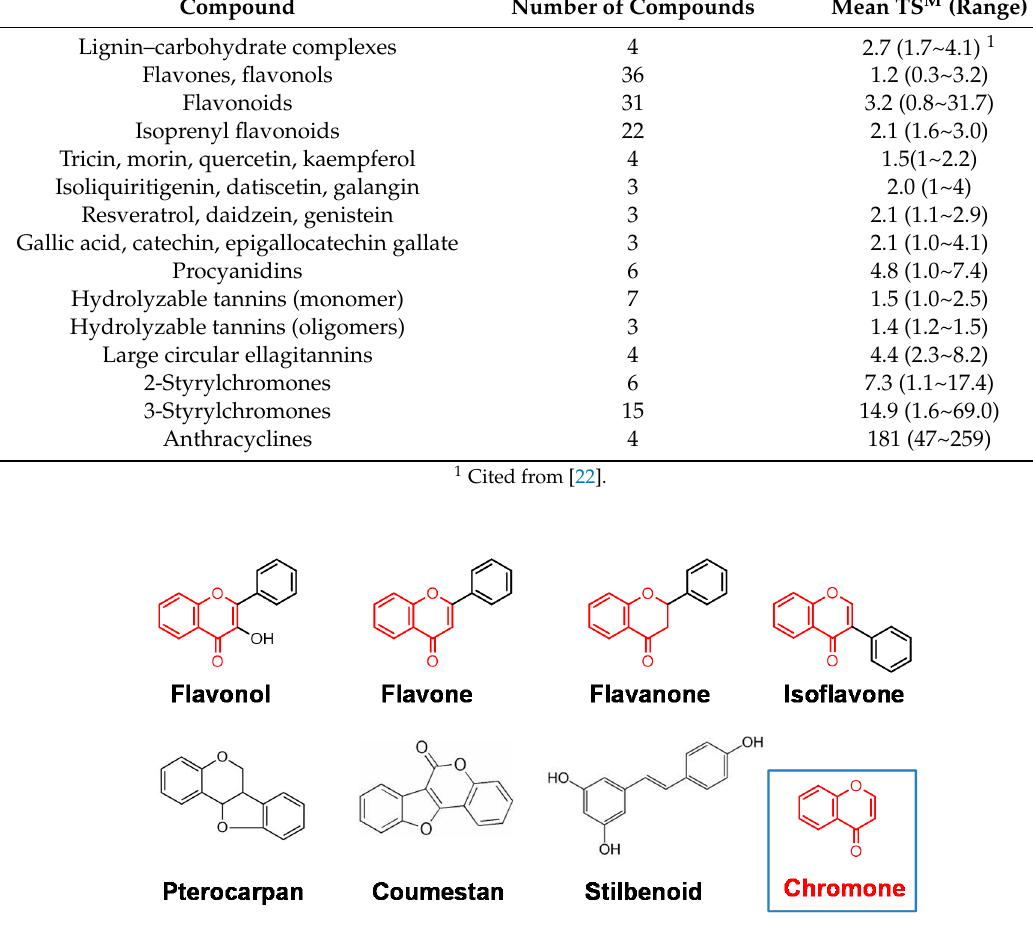
Figure 3. Chromone is a backbone structure of some flavonoids.